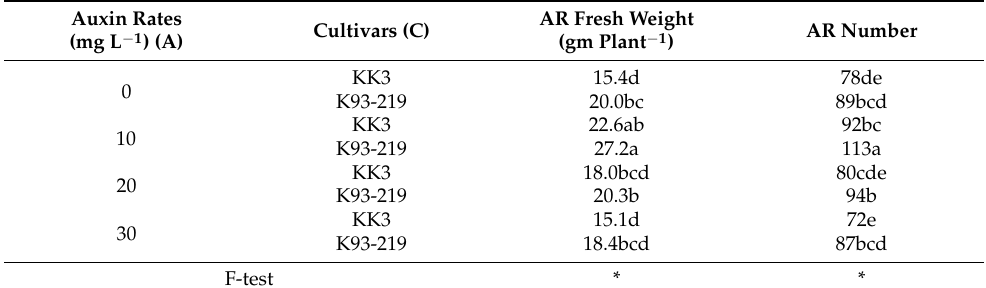
Table 8. Interaction between auxin rates and two sugarcane cultivars in fresh adventitious root weights and adventitious root numbers at 7 days after treatment, Experiment